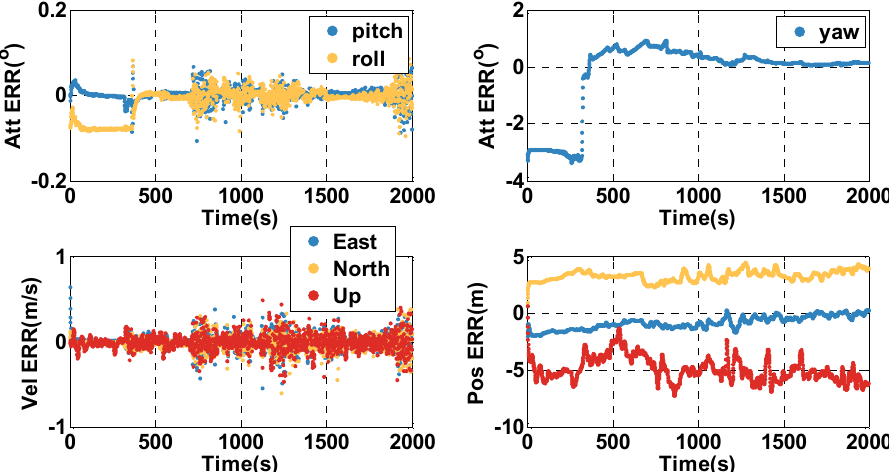
Figure 14. The position, velocity, and attitude errors of the MTF method in the open-sky case.